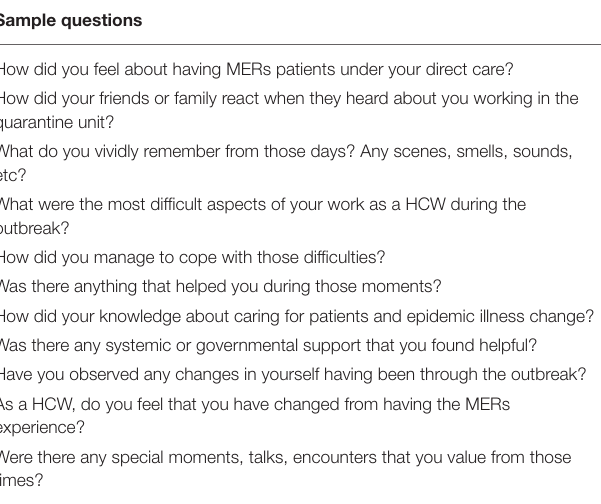
TABLE 1 | Example of open-ended questions for the semi-structured interviews. Sample